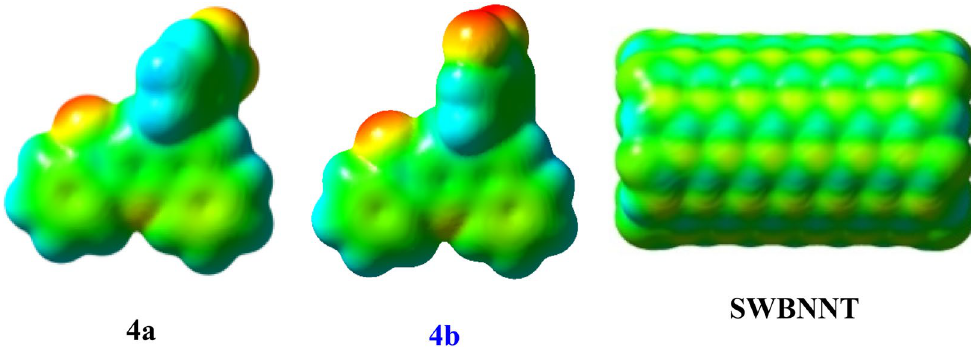
Figure 2. Molecular electrostatic potential (MEP) maps of the 4a, 4b, and single walled boron nitride nanotube (SWBNNT) in ωB97-XD/6-31g* level of theory.